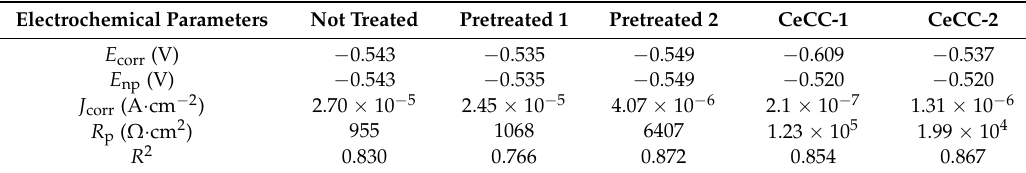
Table 2. Electrochemical parameters calculated from LP curves in Figure 9.